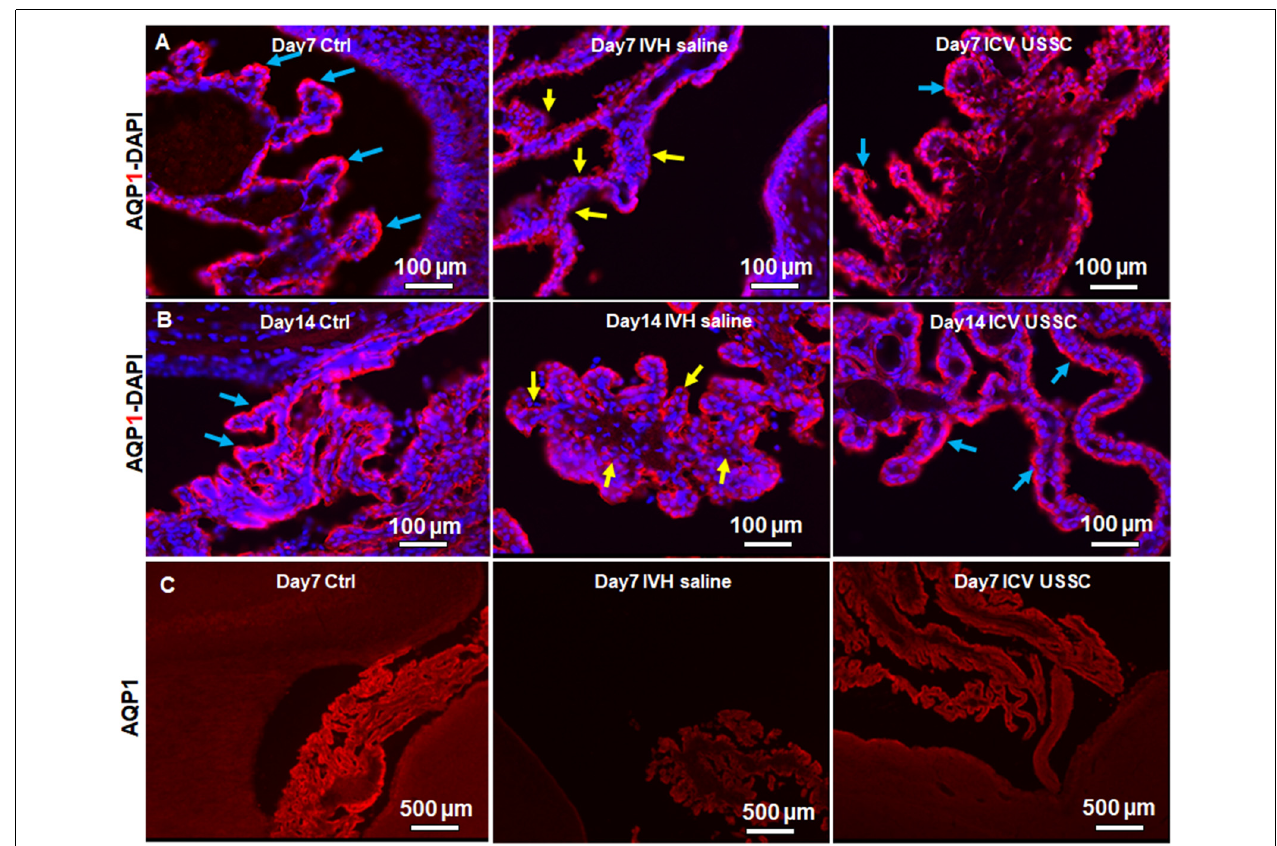
FIGURE 3 | USSC administration recovered aquaporin1 (AQP1) expression in the choroid plexus after PHH. (A) Representative immunofluorescence image of cryosections labeled with AQP1 specific antibody (arrows showing choroid epithelium immunoreactivity) on postnatal days 7. Strong AQP1 immunoreactivity in the control (blue arrows), reduced signal (yellow arrows) in IVH followed by recovered expression (blue arrows), and images from left to right respectively at postnatal day 7. CPE (Choroid plexus epithelial cells). Images were taken at 20 × objective; blue = DAPI stain, 20 µ m sections. Scale bar 100 µ m. (B) Strong AQP1 immunoreactivity in the control (blue arrows), reduced signal (yellow arrows) in IVH followed by recovered expression (blue arrows), and the images from left to right respectively at day 14. Images were taken at 20 × objective; blue = DAPI stain, 20 µ m sections. Scale bar 100 µ m. (C) Representative immunofluorescence image of cryosections labeled with aquaporin1. As seen in the high power image (panel- B above), the strong AQP1 immunoreactivity is evident over the entire choroid plexus in the control, reduced signal in IVH followed by recovered strong AQP1 expression observed in images from left to right respectively at day 14. Images were taken at 4 × objective; 20 µ m sections. The scale bar is 500 µ m. Fluorescence images were taken using “Nikon Eclipse 90i microscope” (Nikon Instruments,